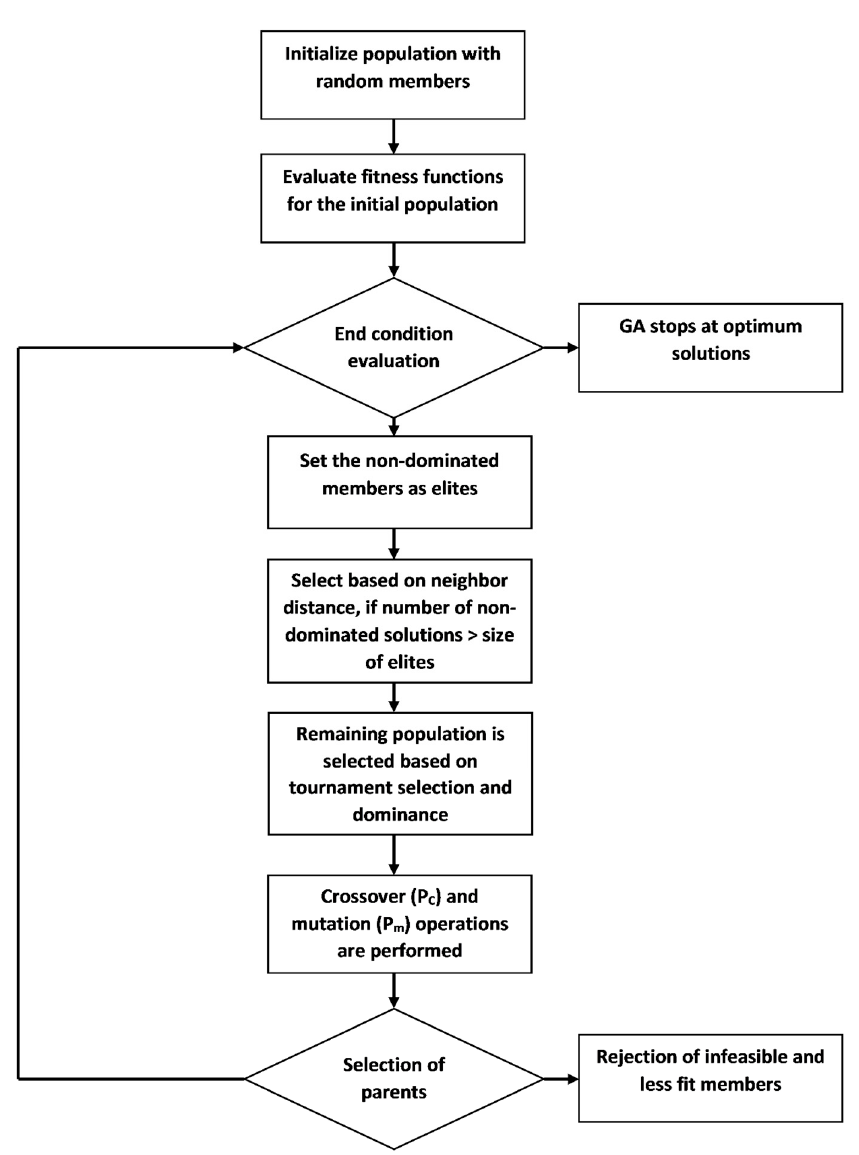
Figure 2. Modified multi-objective evolutionary algorithm (MOEA).